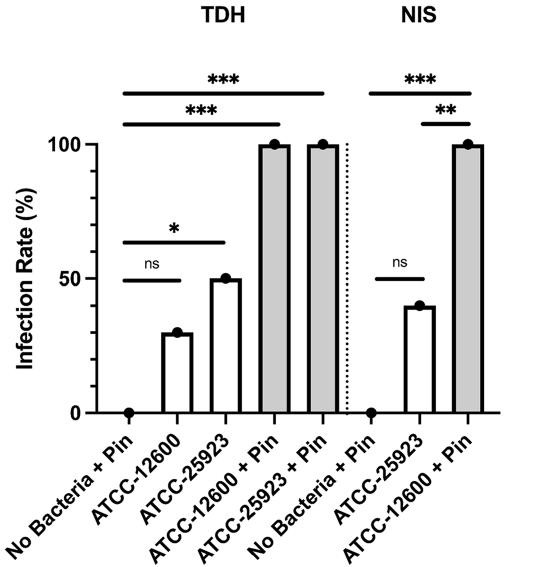
Figure 3. Study 2. The infection rate (%) of the TDH and NIS bone infection models inoculated with free bacteria (ATCC 12600) or biofilm (ATCC 25923) with and without metal pins. The p values are as displayed as follows: ns – no significance, ∗ p ≤ 0 . 05, ∗∗ p < 0 . 01, and ∗∗∗ p ≤ 0 .